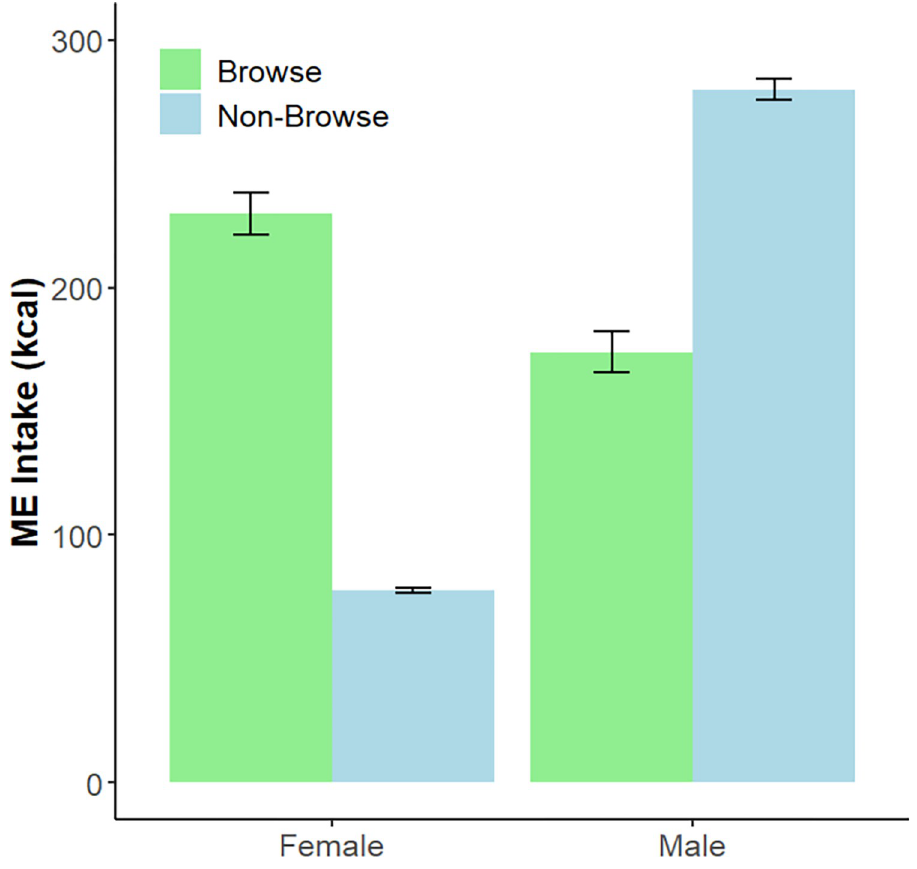
Fig 4. Daily ME intake (kcal day -1 ) attributed to browse and non-browse food items consumed by the female and male Matschie’s tree kangaroo, respectively, over the course of the 14-month study. Error bars indicate the standard error of mean